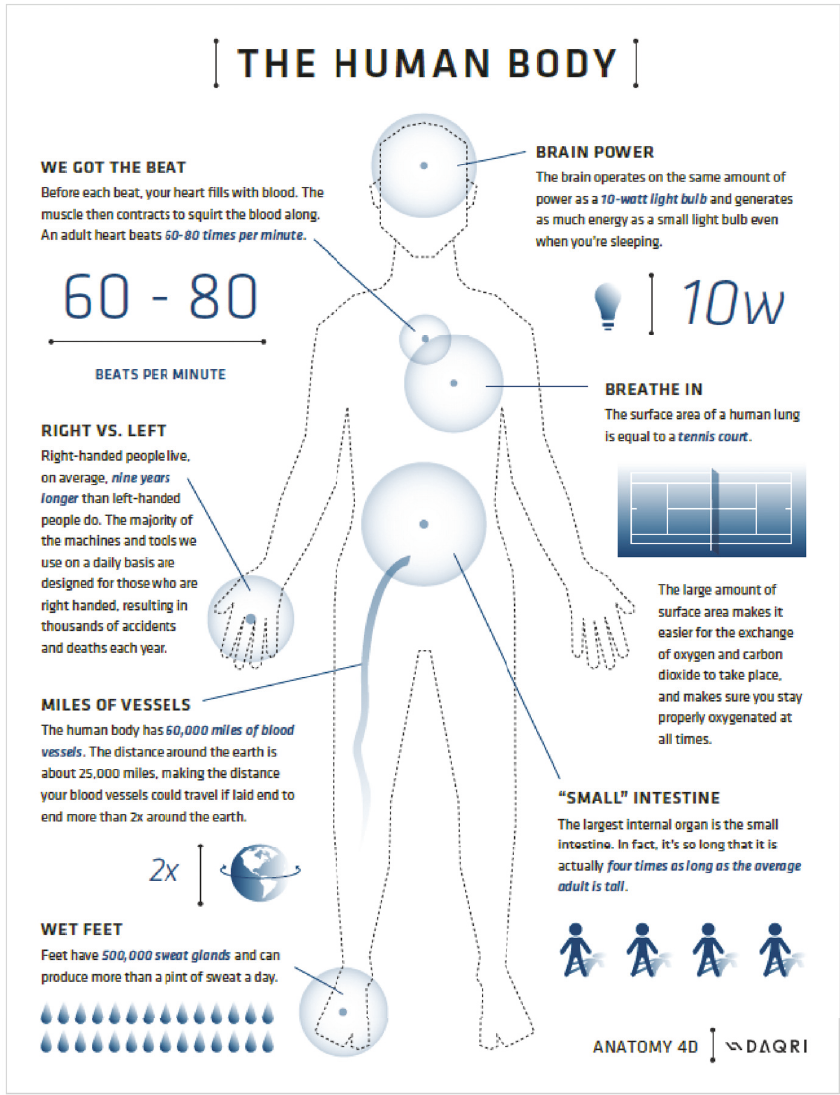
Figure 3: Anatomy 4D target image [16].